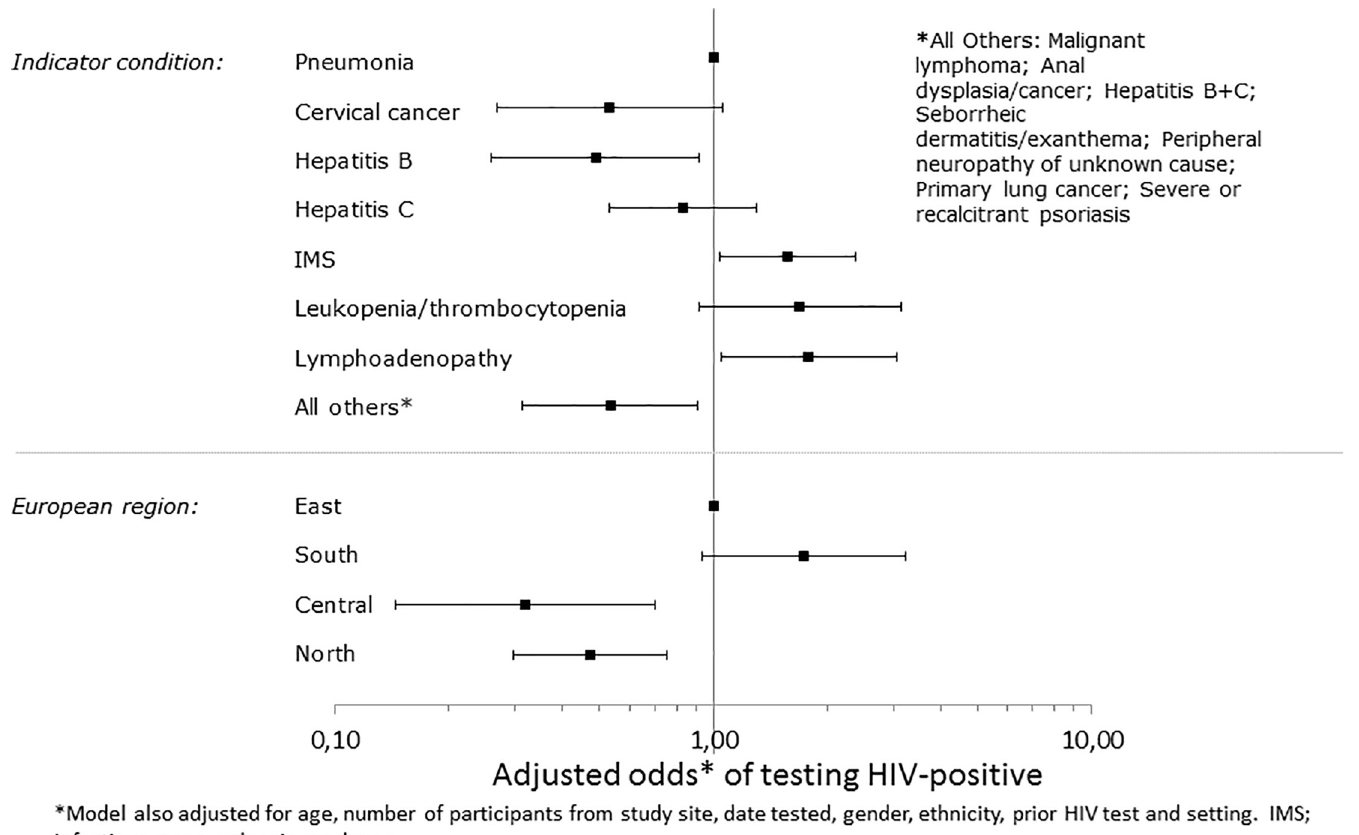
Fig 2. Adjusted odds of testing HIV